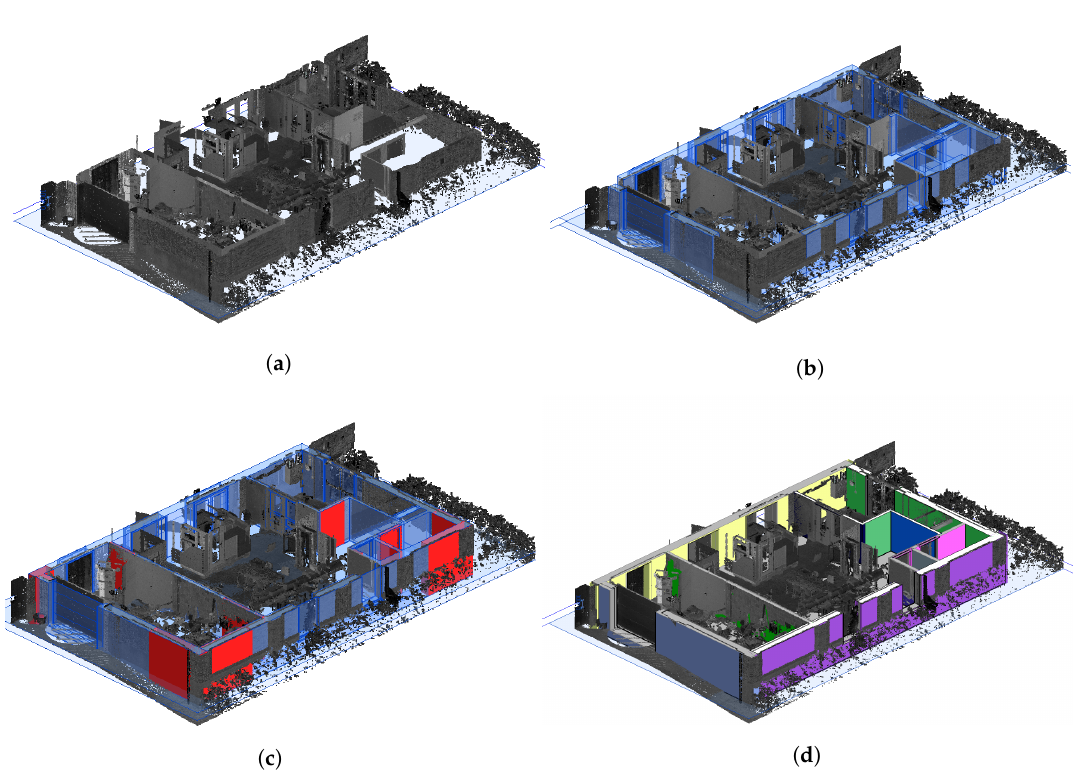
Figure 1. Overview of the Scan-to-BIM procedure from remote sensing point clouds. ( a ) Point cloud data ( b ) Extracted building components ( c ) Geometry reconstruction in occluded areas ( d ) BIM topology